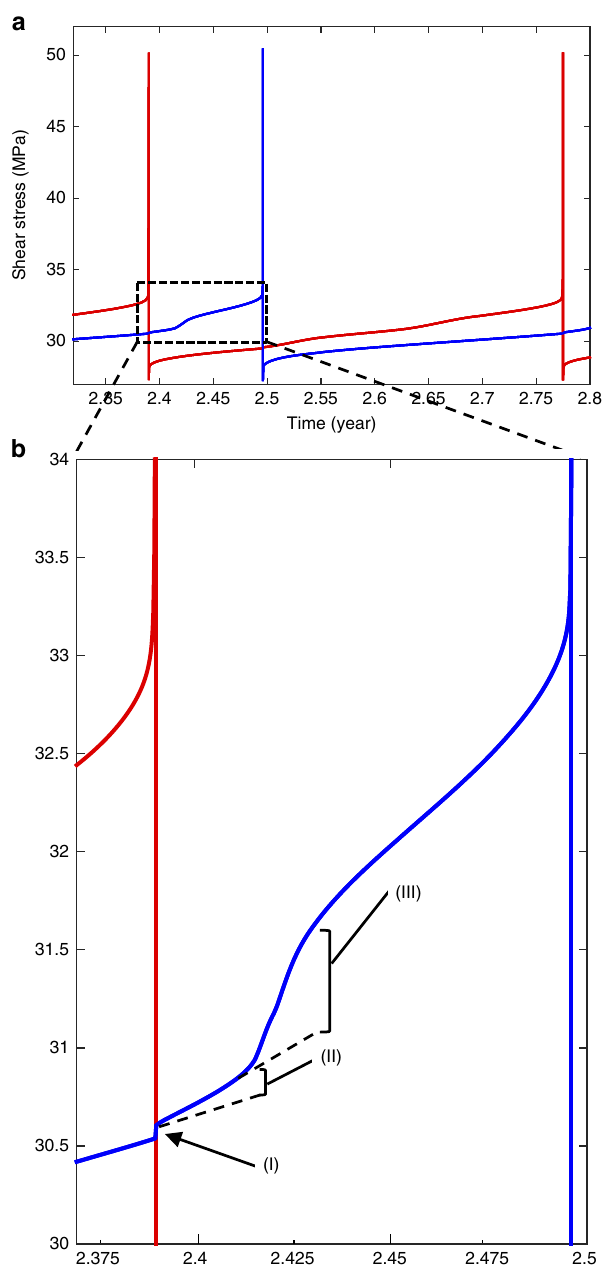
Figure 3 | Different types of stress changes induced on the triggered VW patch. ( a ) Shear stress as a function of time in the centre of the triggering patch (red line) and triggered patch (blue line). ( b ) Zoom into the dashed rectangle of the top panel shows three types of stress increases in the triggered patch: (I) direct static stress change due to coseismic slip on the other patch; (II) stress change due to elevated stressing rate in the VS region adjacent to the triggered patch; (III) stress change due to propagating postseismic creep. Postseismic stress changes (II) and (III) are clearly much larger than the stress change (I) due to coseismic slip